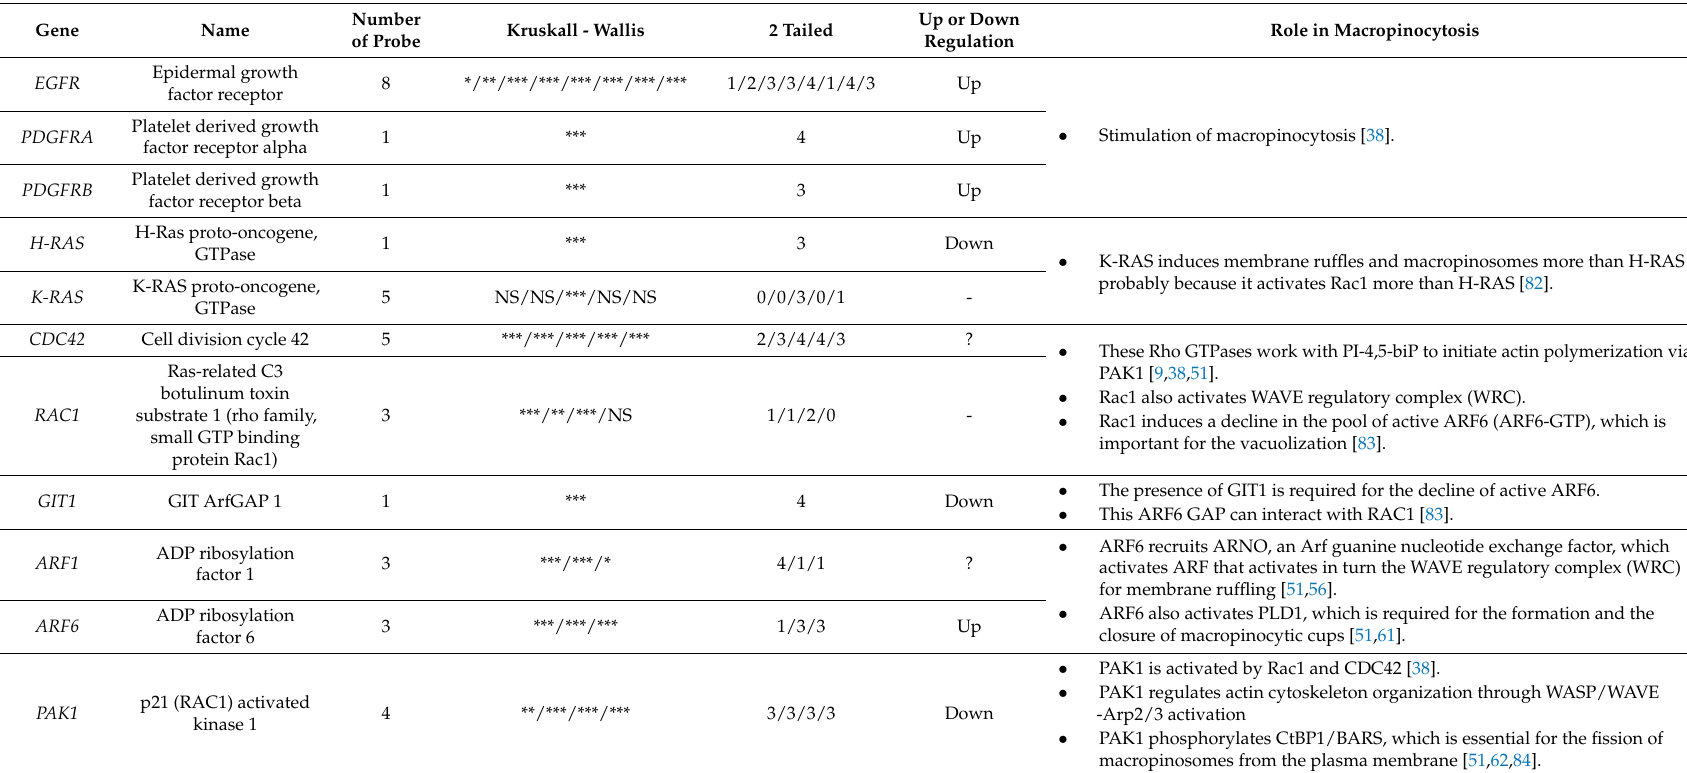
Table A1. Statistical comparison of mRNA expression data of macropinocytosis gene probes in the GSE4290 dataset. Kruskall–Wallis results are provided per probe (probe 1/probe 2/ . . . ). NS: p > 0.05; *: p < 0.05; **: p < 0.01; ***: p < 0.001. The number of two-tailed significant results per probe is then provided in a similar way: e.g., 0/1/0 means for probe 1 that no two-tailed comparison reached significant threshold ( p < 0.05), for probe 2, one two-tailed comparison turned out significant, and again no significance was found between groups for probe 3. Note that the maximum comparison number is 5. ?: inconsistent results depending on the probe